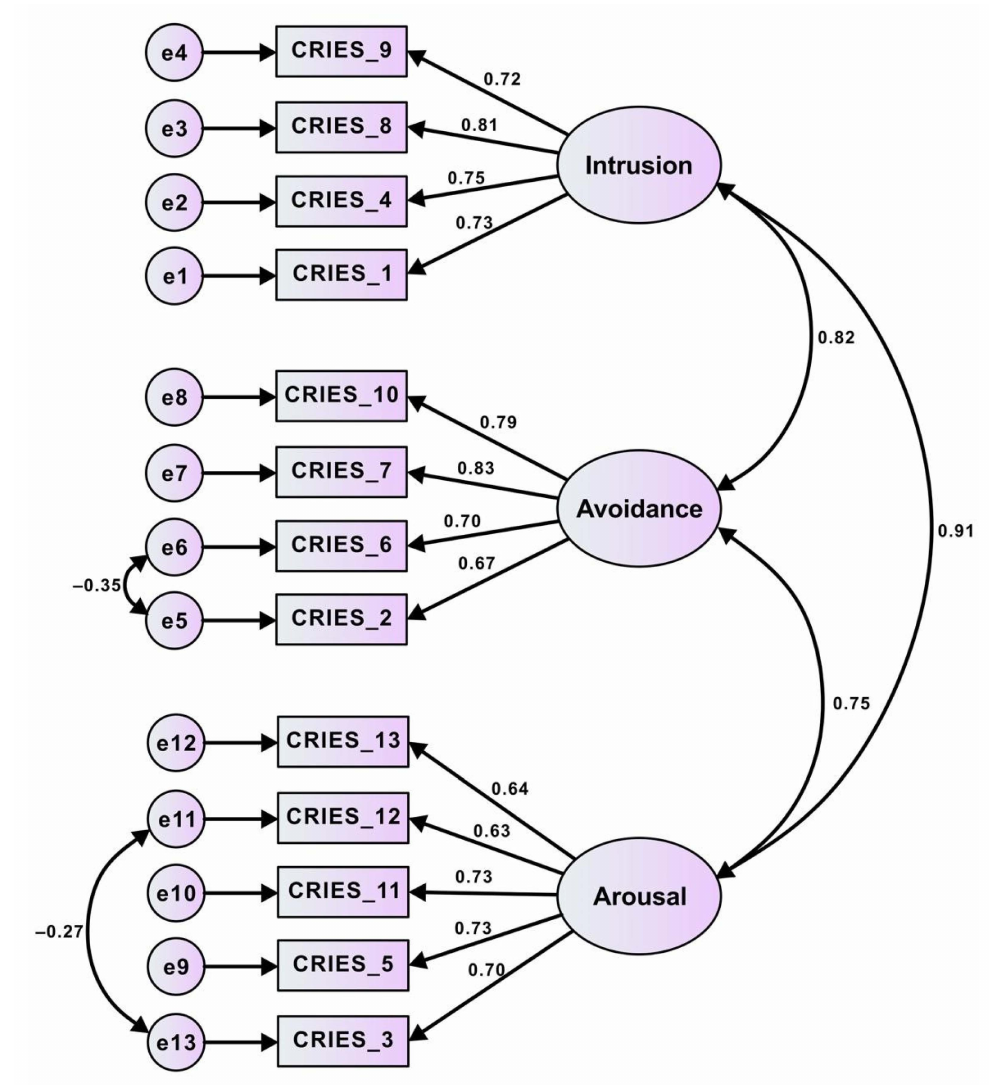
Figure 1. Three-structure model of Children’s Revised Impact of Event Scale 13 (CRIES-13) for all participants